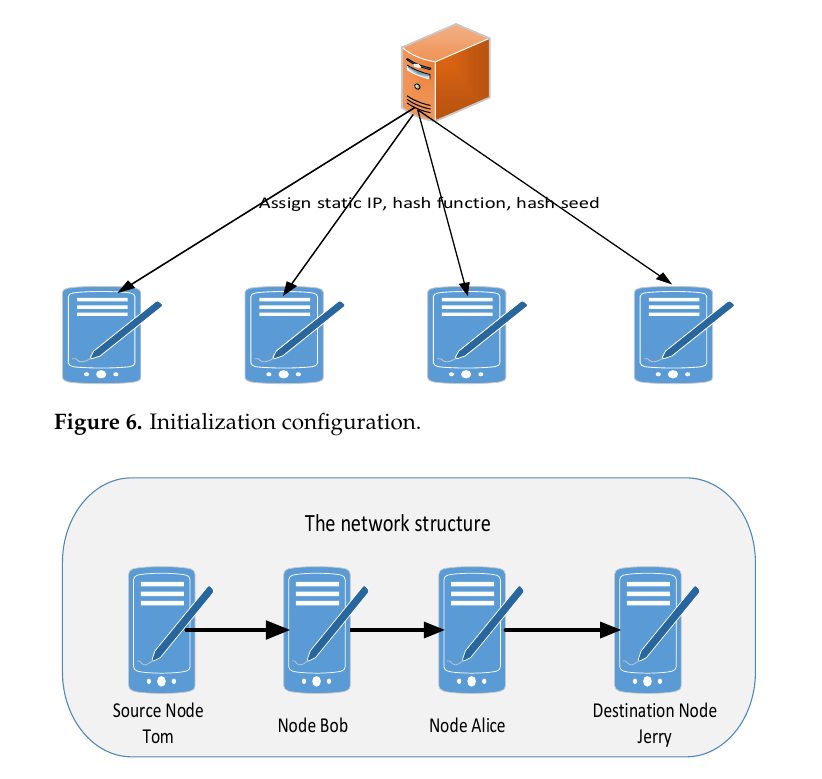
Figure 7. Network Structure.